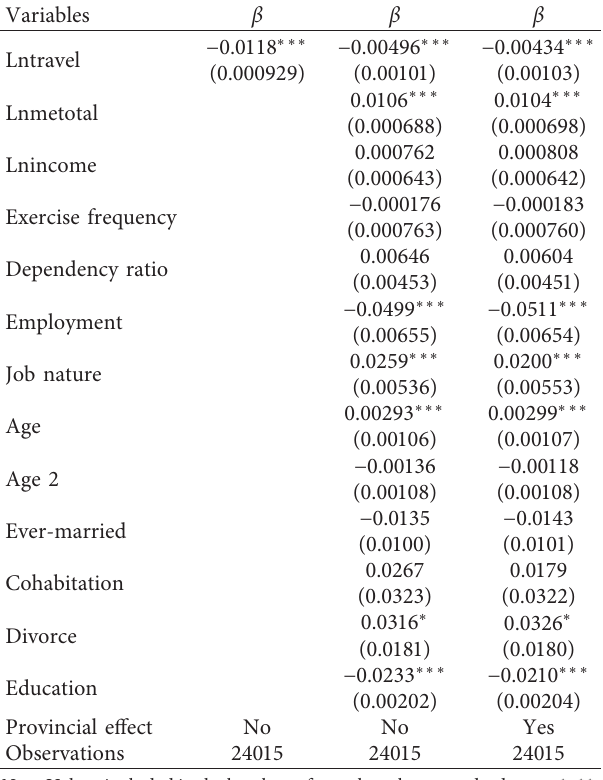
Table 4: Result of evaluation of other negative moods in Probit